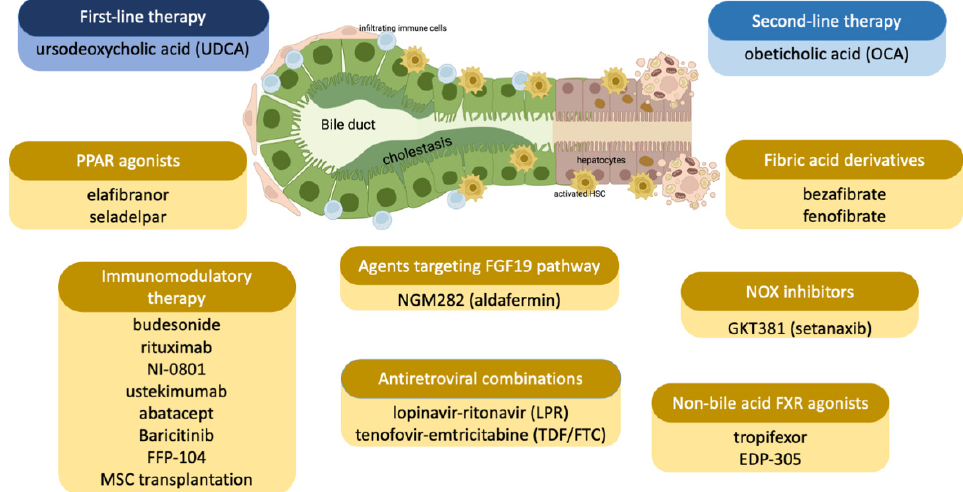
Figure 1. Drugs approved (in blue) or under evaluation (in yellow) for the treatment of PBC.